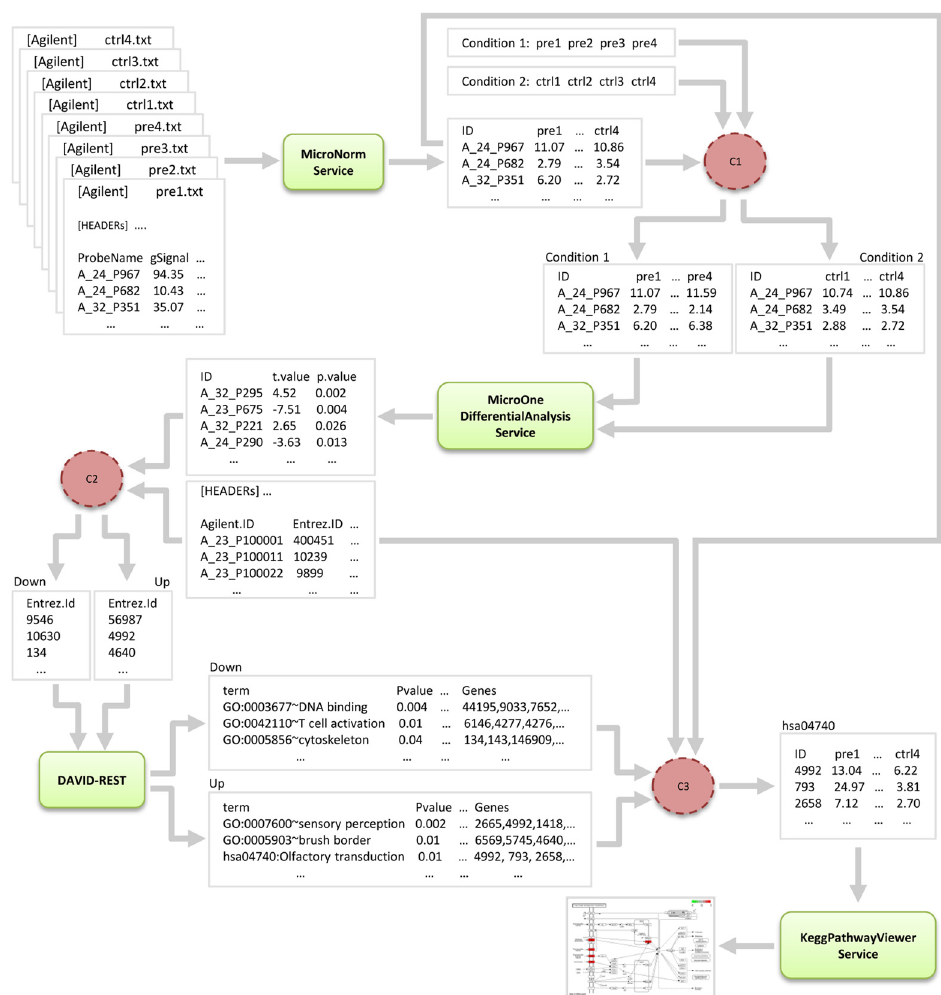
Fig 7. One-color microarray data analysis scenario service architecture. A rectangle represents a data source, while a rectangle with rounded corners represents a RESTful analysis service. A dotted circle represents a RESTful software connector. An one-way arrow represents a directed flow of data and/or control.